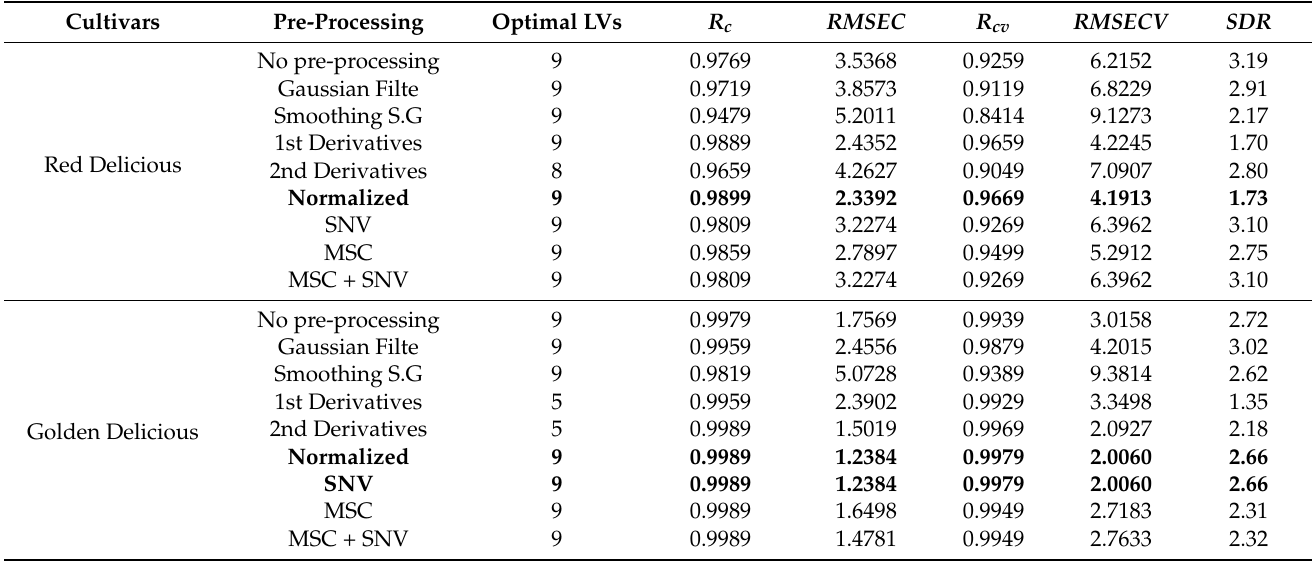
Table 6. Validation results of PLS models based on different hyperspectral imaging pre-processing methods for phenol of Red Delicious and Golden Delicious cultivars.